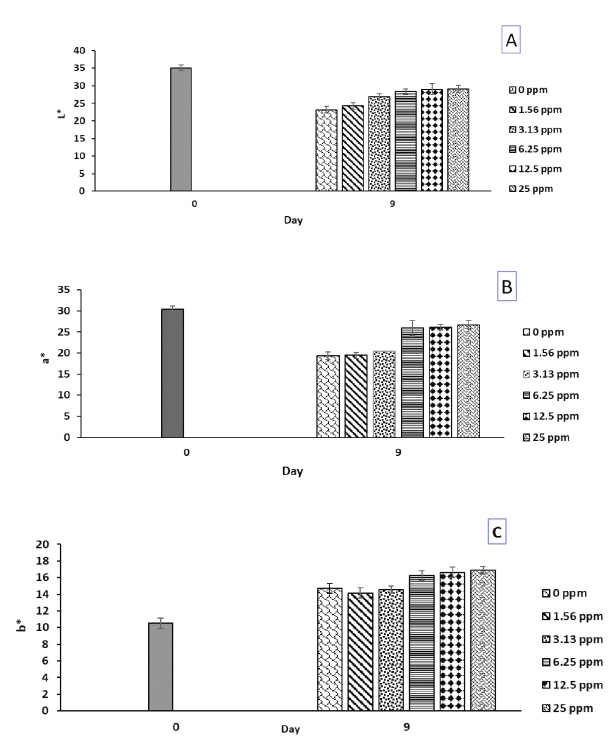
Fig. 1 ­ The influence of cumin EO concentrations on the L* (A), a* (B), and b* (C) values under different observation periods in cold stored­radishes. Means ± SD of six repli­ cates of two seasons are given (Tukey,